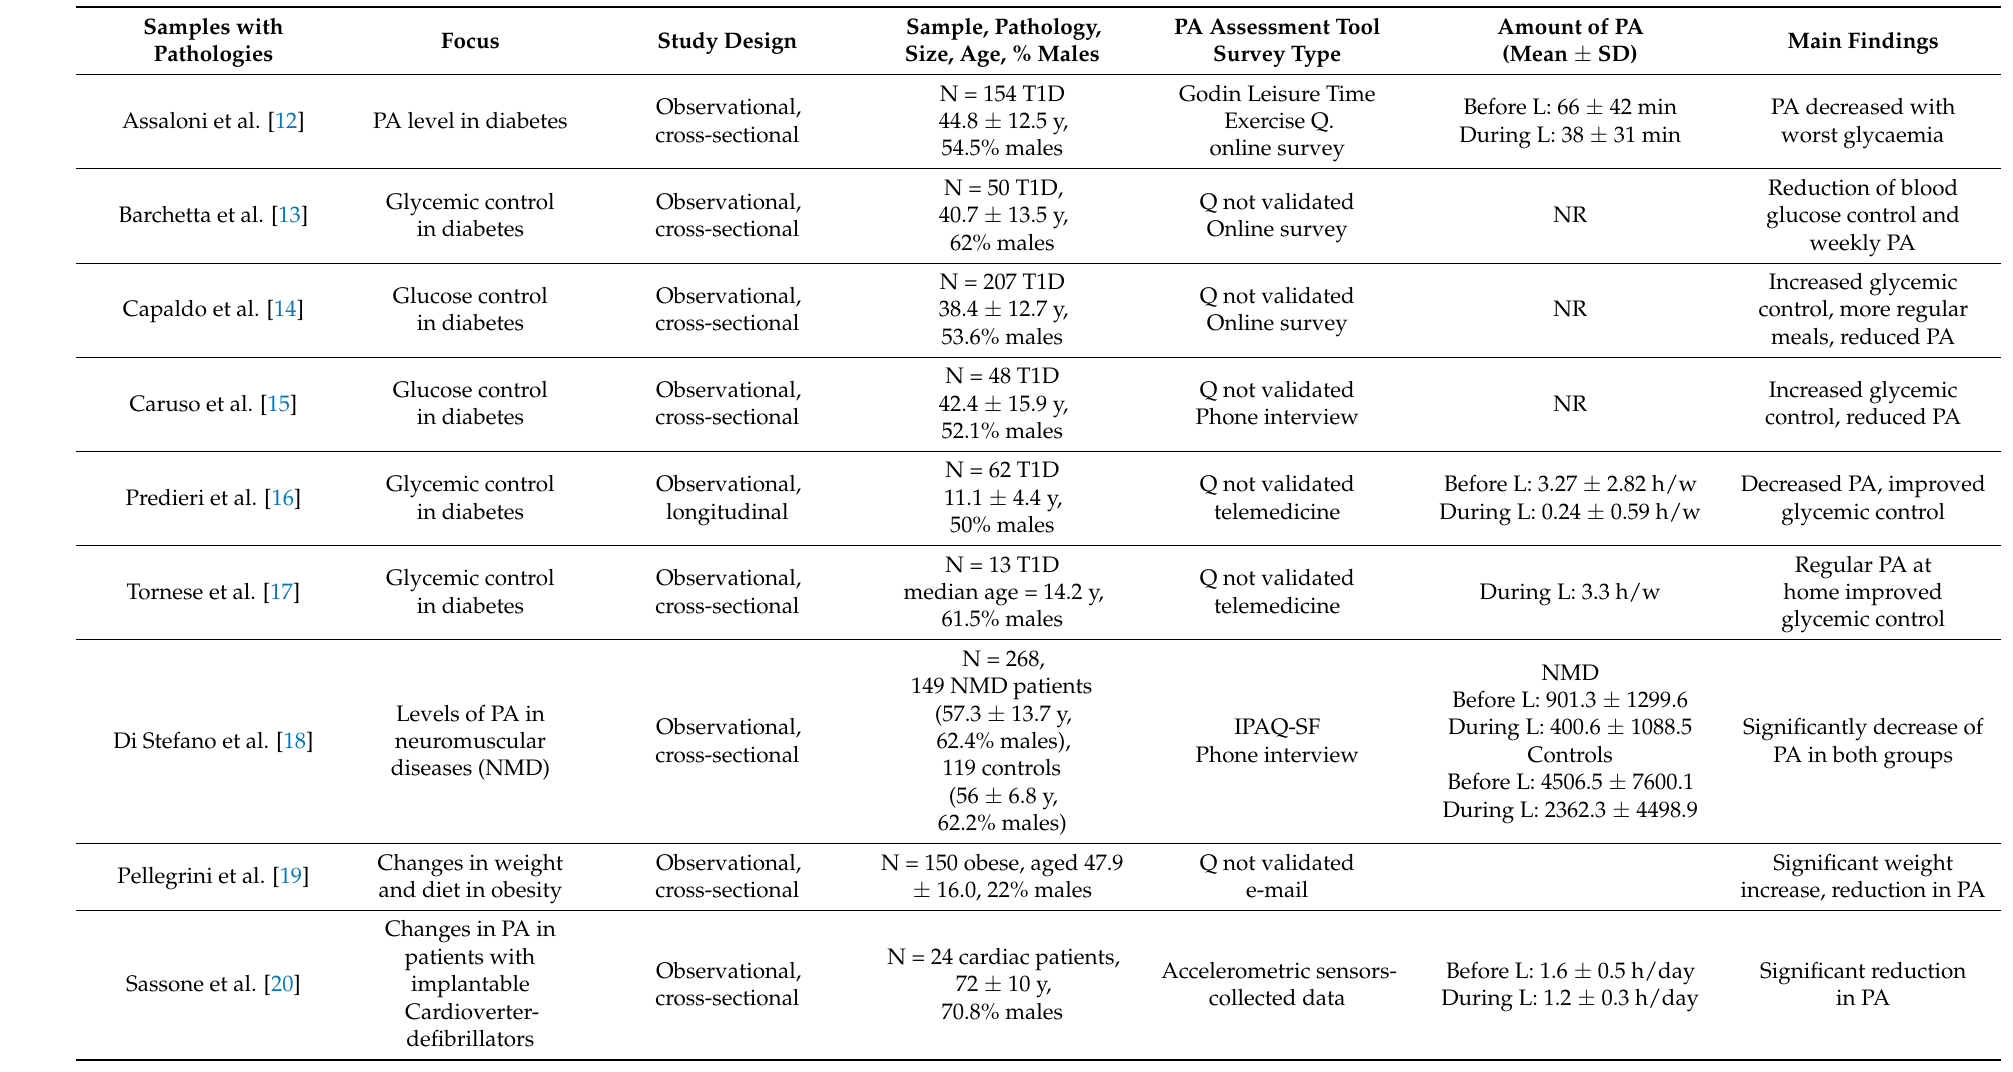
Table 1. Description of the characteristics of the included